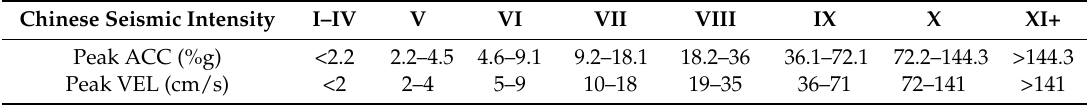
Table A1. The abbreviated Chinese seismic intensity